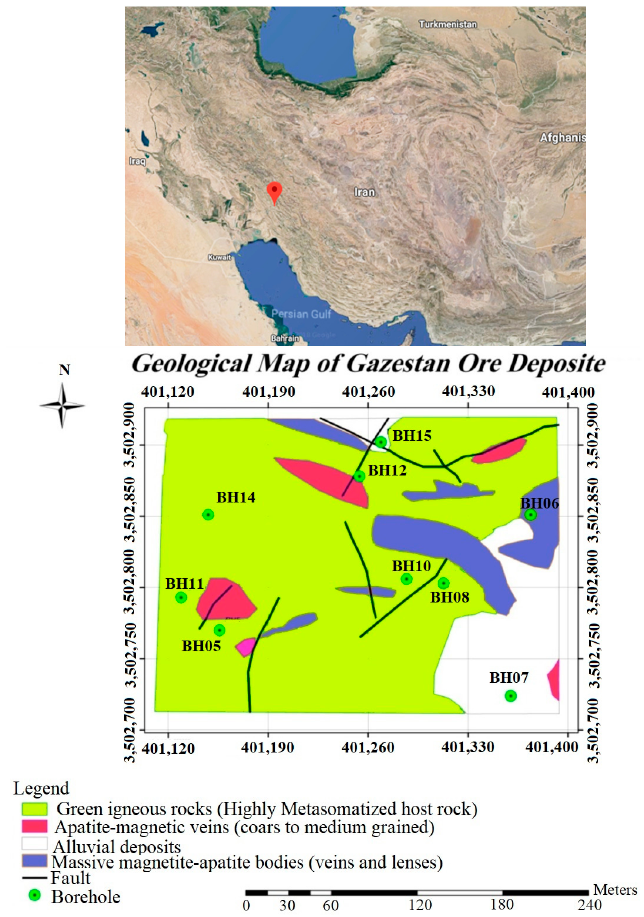
Figure 2. Geological map and location of 9 boreholes and the study area.